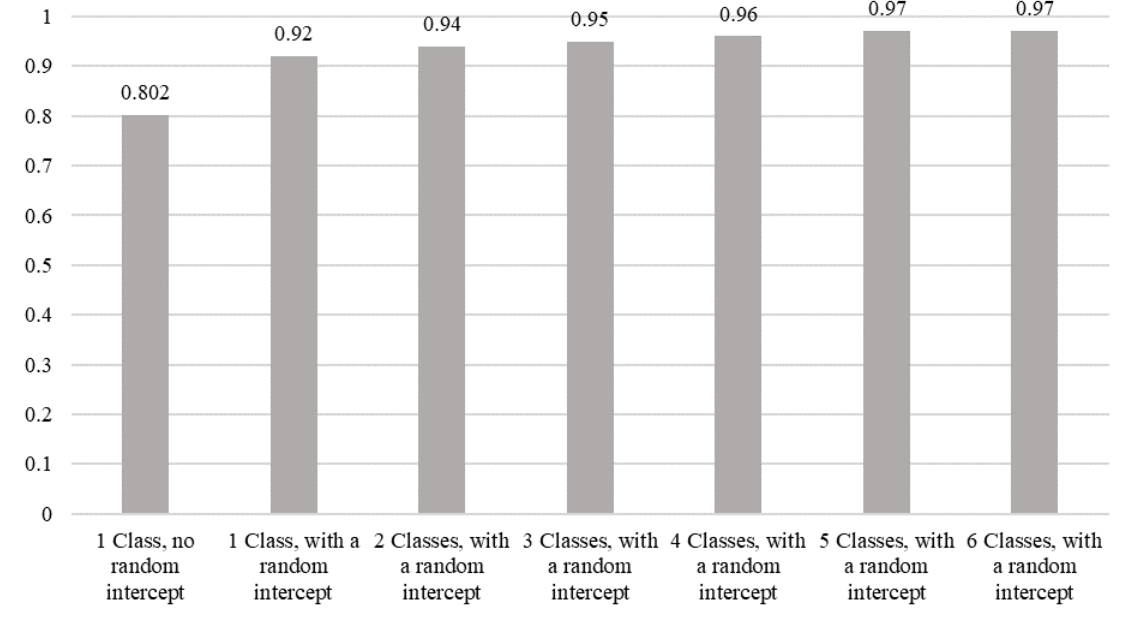
Figure 5. AUC values for the ROC curves of the models with a different number of latent classes.